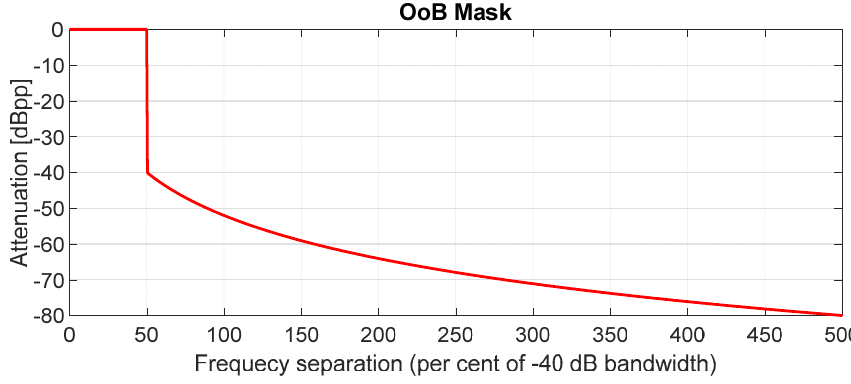
Figure A1. Design objective for radar systems.